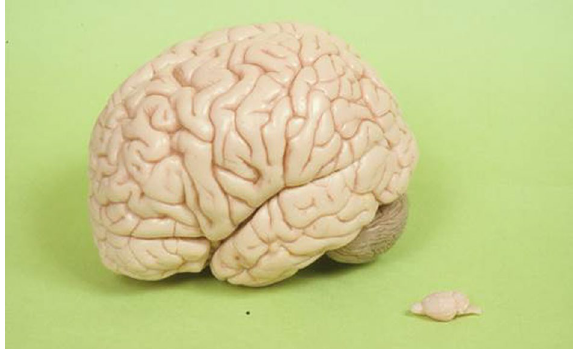
Fig. 11 Comparison of a human brain and a rat brain